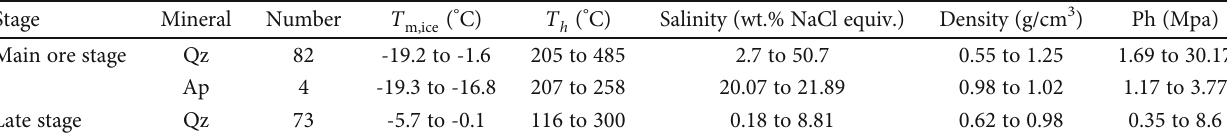
Table 4: Microthermometric data of fl uid inclusions from the Xinmin deposit.